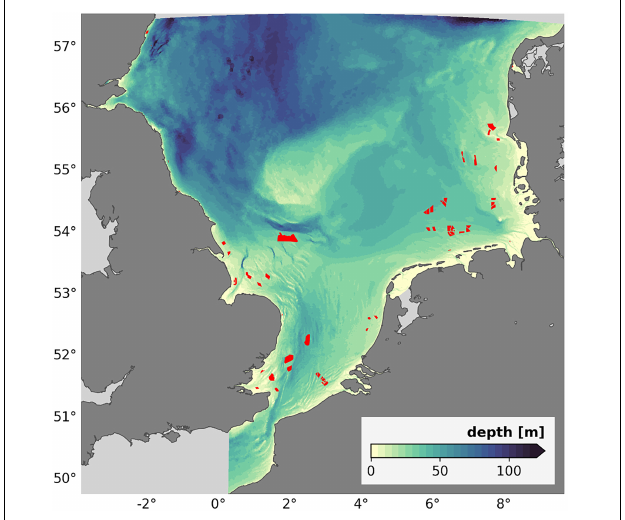
FIGURE 1 | Bathymetry of the model domain (data downloaded from https://www.emodnet-bathymetry.eu/, June 2019) and the fully commissioned offshore wind farms in the southern North Sea, which were considered in this study (red polygons; status as of November 3, 2020, data provided by